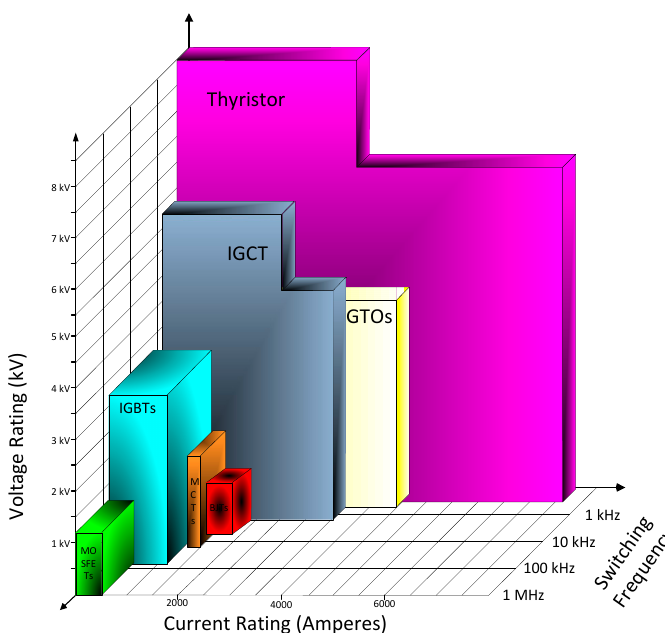
Figure 4. Voltage and current rating of solid-state switches.